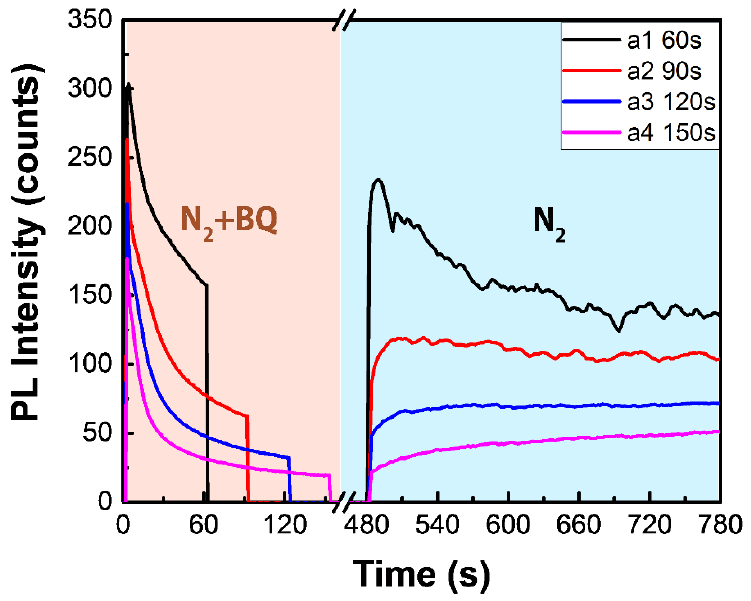
Figure 2. PL kinetics show BQ vapor treatment results with different irradiation durations (at 532 nm) on four areas in the same sample. After BQ vapor treatment, the sample chamber was purged with dry N 2 for 5 min to remove the residual BQ.